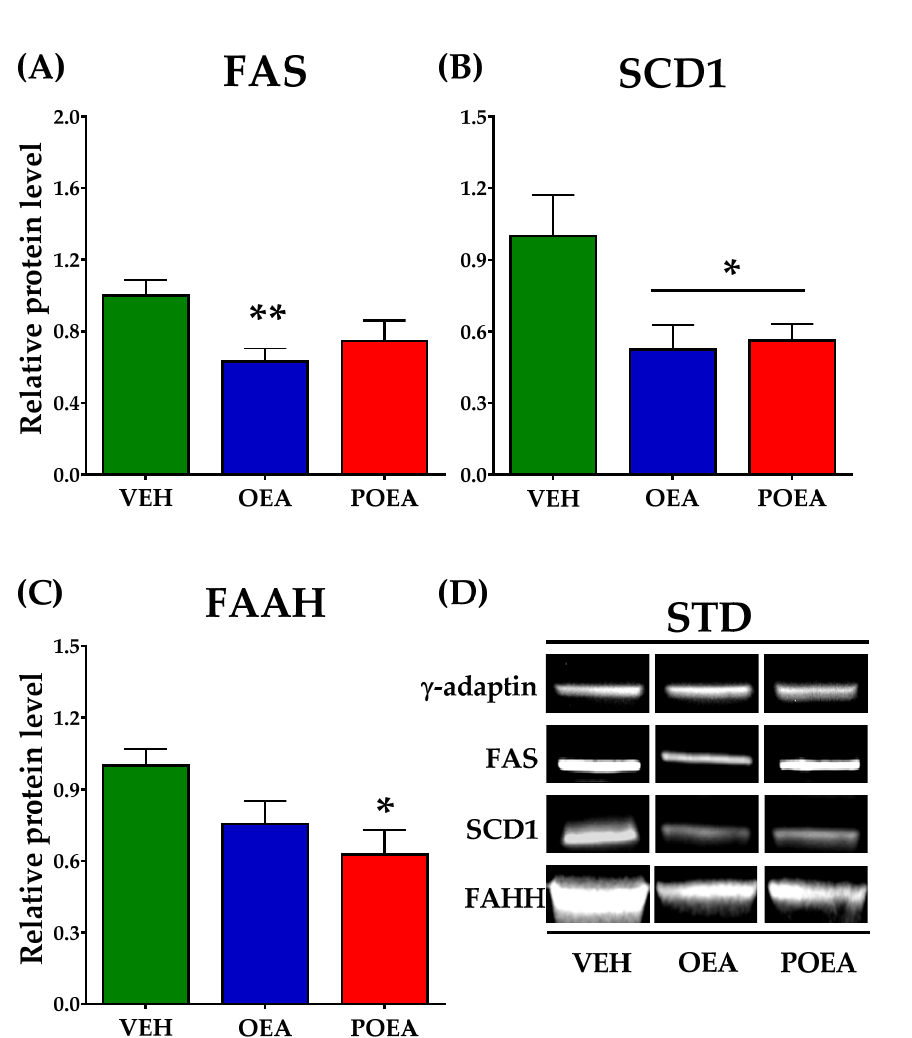
Figure 8. Analysis of liver protein expression of lipogenic enzymes and N-acylethanolamines (NAEs) degrading enzyme after sub-chronic (15 days) administration of a 10 mg/kg dose of either oleoylethanolamide (OEA) or palmitoleylethanolamide (POEA) in standard diet (STD)-fed Sprague–Dawley rats. Fatty acid synthase (FAS) ( A ), stearoyl-CoA desaturase (SCD1) ( B ), and fatty acid amide hydrolase (FAAH) ( C ) were analyzed by imaging densitometry. The bars show the results from six independent samples for each treatment group. ( D ) Representative images of Western blot analysis of liver samples for each treatment. The corresponding expression of γ -adaptin is showed as a loading control per lane. All samples were derived at the same time and processed in parallel. The bars were determined the means and corrected for γ -adaptin protein as reference ± standard error of the mean (SEM) ( n = 6 samples per group). Unpaired t -test: (*) p < 0.05 and (**) p < 0.01 vs. vehicle (VEH) group.